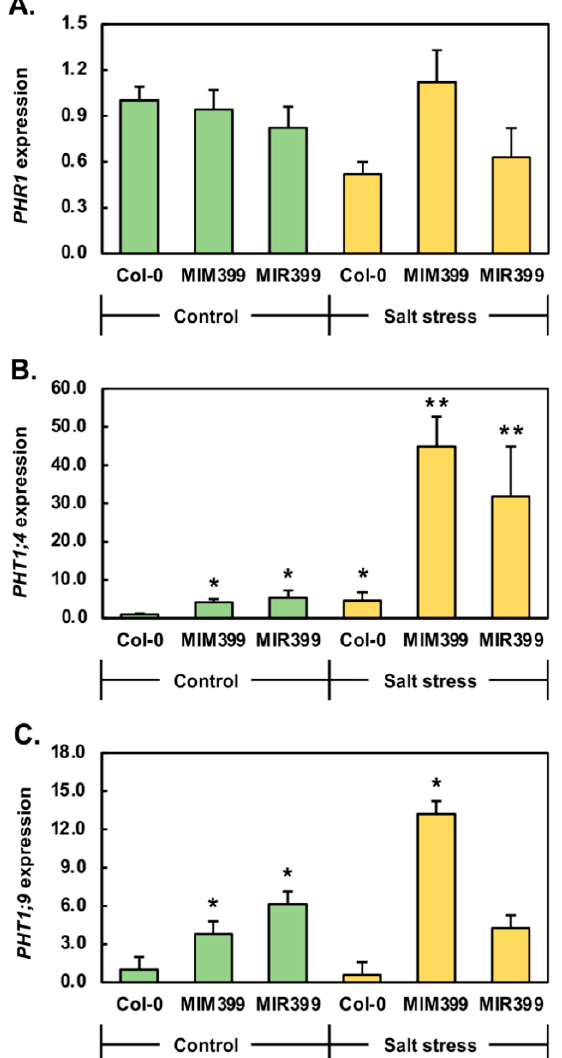
Figure 4. Quantification of PHR1 , PHT1;4 and PHT1;9 expression via RT-qPCR analysis of control and salt-stressed Col-0, MIM399 and MIR399 15-day-old Arabidopsis seedlings. Assessment of the expression of PHR1 ( A ), PHT1;4 ( B ) and PHT1;9 ( C ) in 15-day-old control and salt stressed Arabidopsis plant lines, Col-0, MIM399 and MIR399 . Error bars represent the standard deviation of four biological replicates and the presence of an asterisk above a column represents a statistically significantly difference in the abundance of an assessed transcript between the compared Col-0, MIM399 and MIR399 plant lines ( p -value: * < 0.05; ** < 0.005).